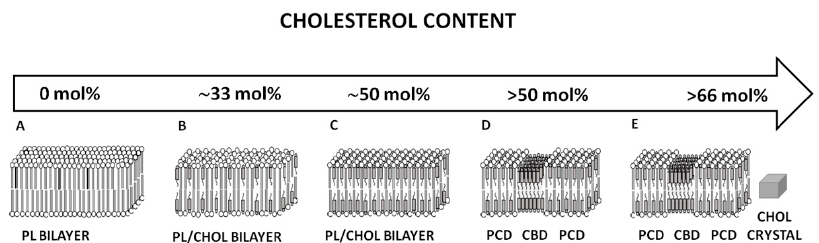
Figure 5. Schematic drawing of changes in the organization of the sphingomyelin bilayer as a function of cholesterol content. ( A ) Pure sphingomyelin bilayer, ( B , C ) sphingomyelin / cholesterol bilayer, ( D ) sphingomyelin / cholesterol domain (PCD (phospholipid / cholesterol domain)–bilayer saturated with cholesterol) coexisting with CBD (cholesterol bilayer domain), and ( E ) PCD coexisting with CBDs and new phase cholesterol crystals. Cholesterol limits were taken from [48]. Please note that sphingomyelins account for ~66% of the total phospholipids in the plasma membranes of human eye lens fiber cells [47,54].